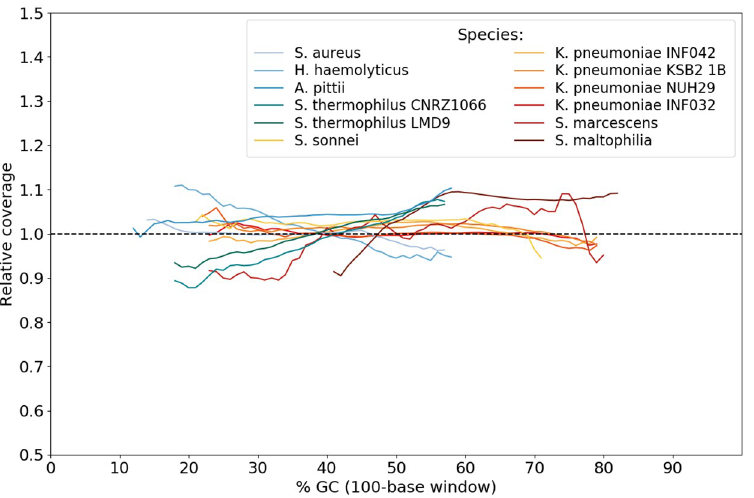
Fig 3. Relative coverage for each bacterial species, according to local GC content. The black dotted line represents a GC-unbiased depth of coverage. Only points associated with at least 1000 windows in the genome were plotted.